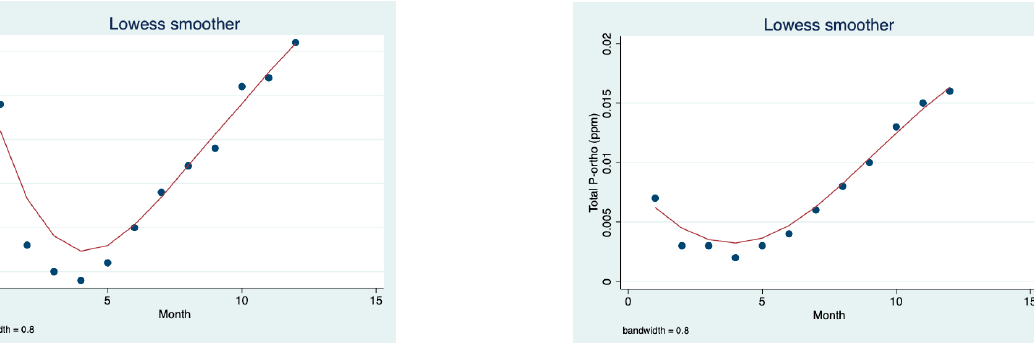
Figure 16. Lowess smoother (0.8 bandwidth) trend of changes plot of monthly changes of nitrate concentrations (ppm scale range: 0.0–0.3) (1969–2001).